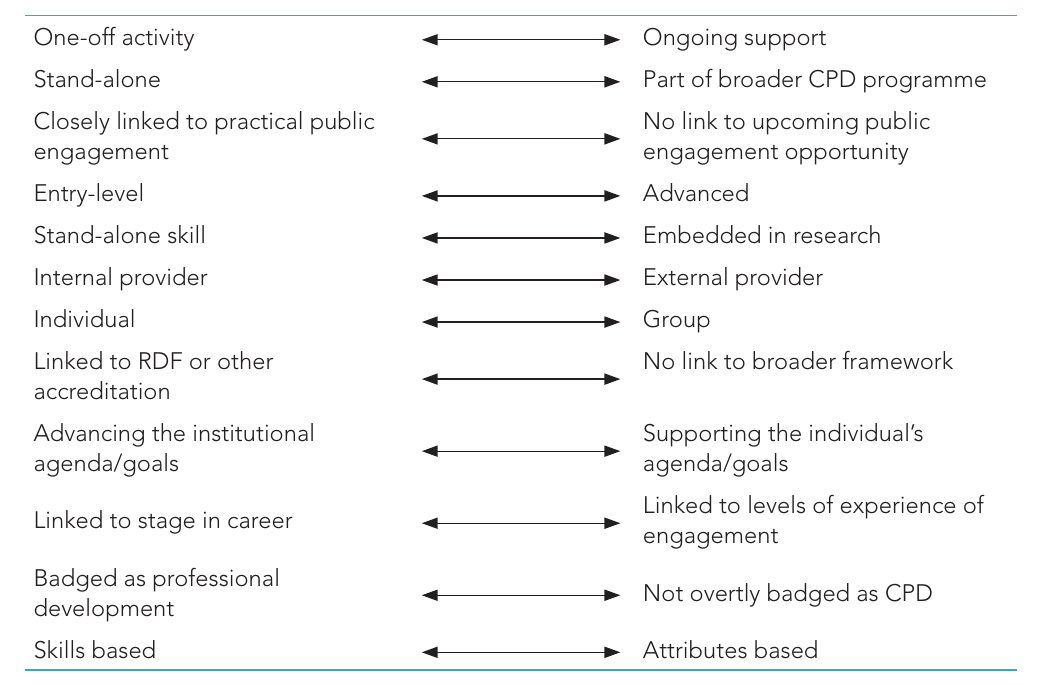
Table 1: Dimensions of formal CPD